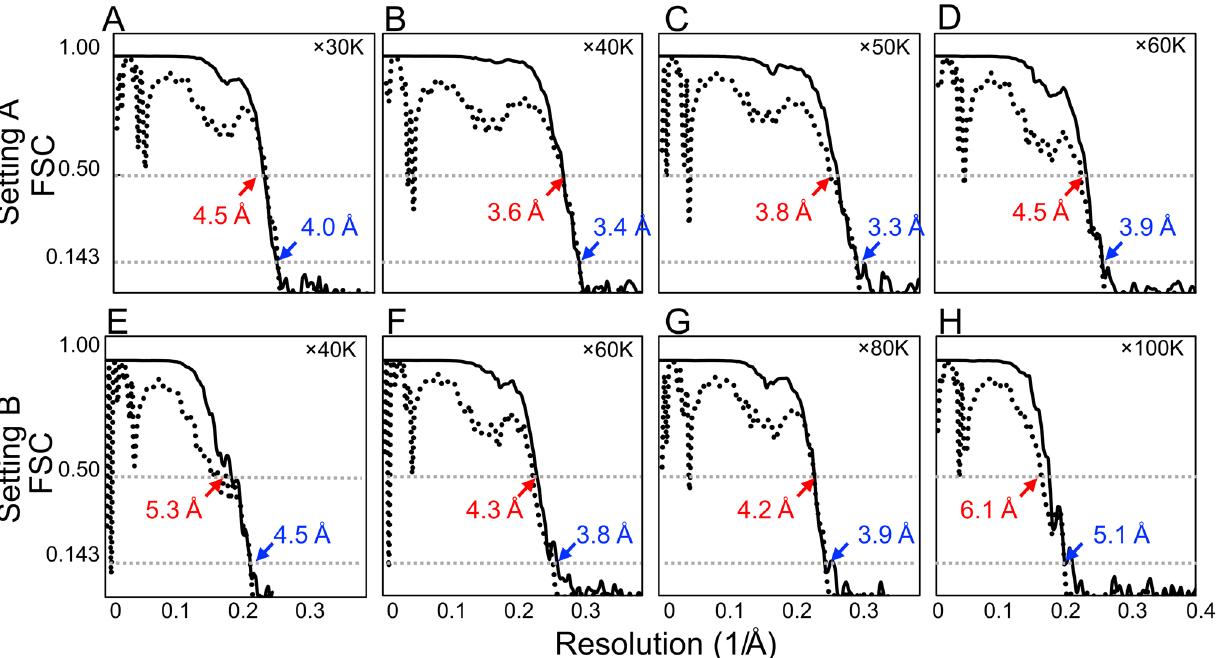
Figure 6. GS-FSC and MM-FSC plots of all reconstructions. GS-FSC (solid lines) was calculated from independent half maps, and the resolutions was estimated at 0.143 cut-off (blue labels). MM-FSC (dashed lines) were calculated between 3D reconstructions and maps calculated from the PDB model (2CIH), and the resolution was estimated at 0.5 cut-off (red labels). The experimental conditions are × 30 K ( A ), × 40 K ( B ), × 50 K ( C ), and × 60 K ( D ) magnifications using Setting A, and × 40 K ( E ), × 60 K ( F ), × 80 K ( G ), and × 100 K ( H ) magnifications using Setting